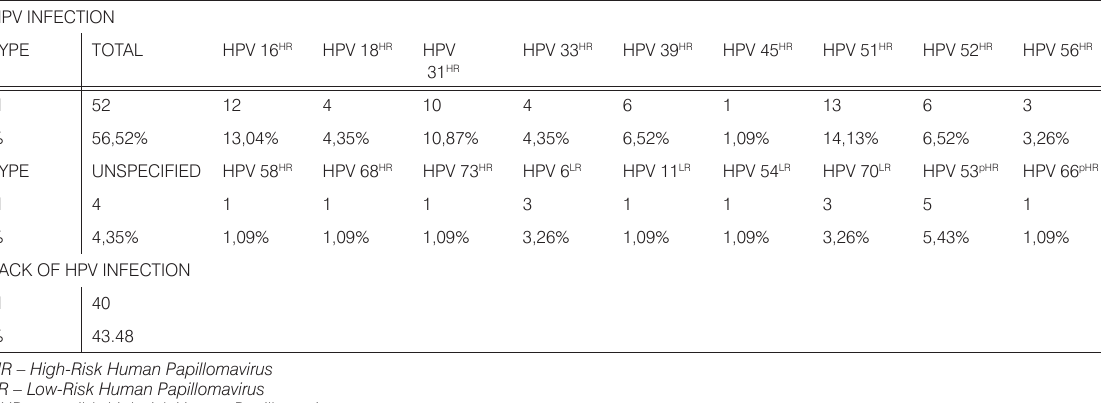
Table 1. The prevalence of HPV infection in the studied population (n = 92) with regard to particular types of